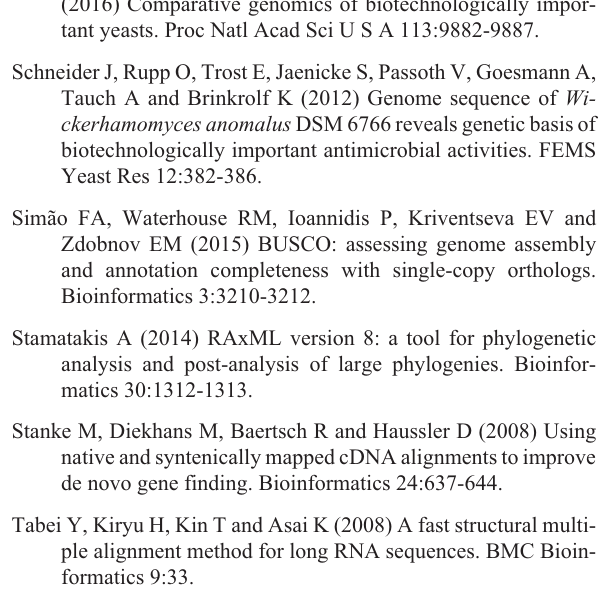
Figure S1 - Maximum Likelihood (ML) phylogenetic tree based on DNA sequences from large ribosomal subunit (LSU), small ribosomal subunit (SSU) and Elongation Fac- tor-1 (cid:4) (EF-1 (cid:4) ). Figure S2 - Venn Diagram of Groups of Orthologous Genes between W. anomalus LBCM1105 (LBCM1105-A: Augus- tus, LBCM1105-B: BRAKER2), W. anomalus NRRL Y- 366-8, W. ciferrii NRRL Y-1031 and S. cerevisiae